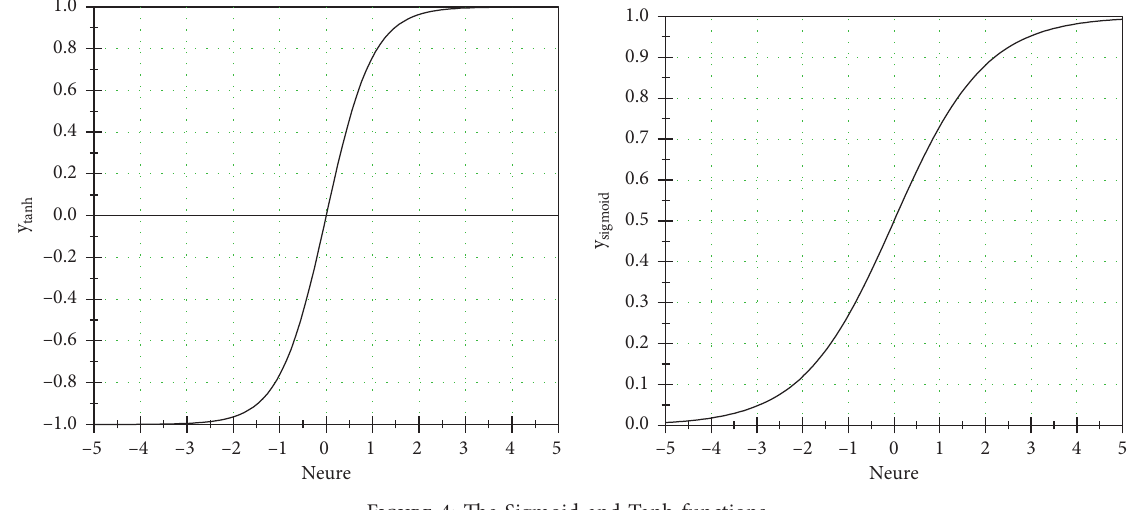
Figure 4: The Sigmoid and Tanh